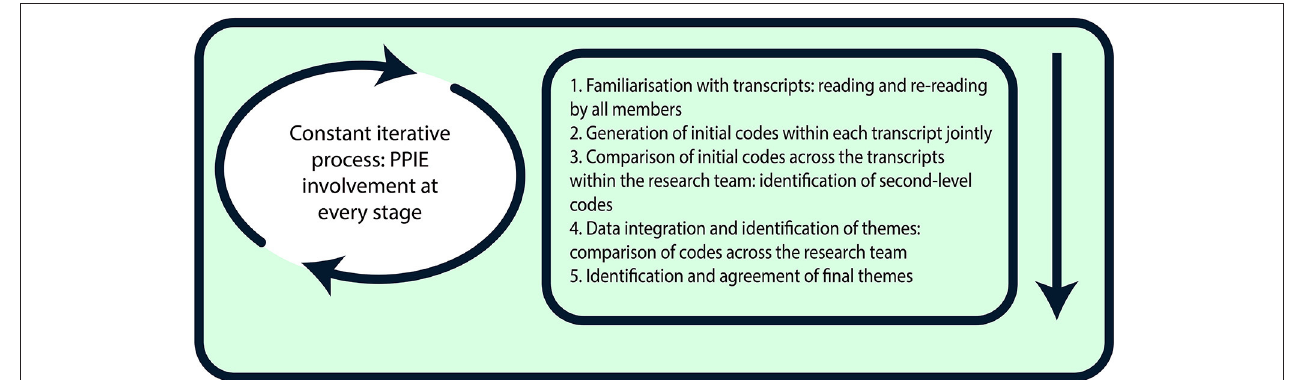
FIGURE 1 | Thematic analysis